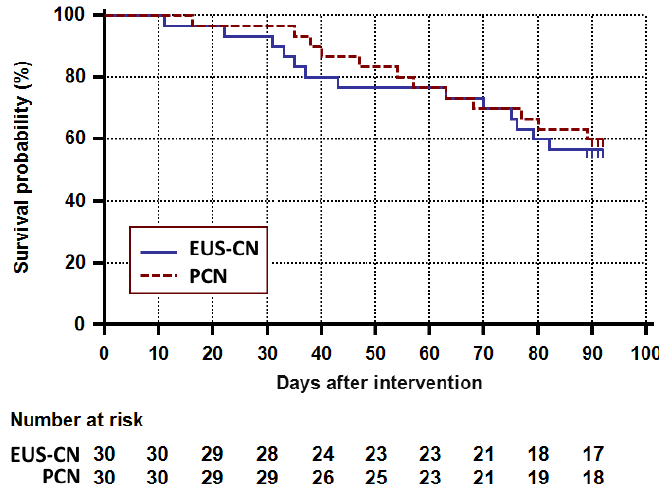
Figure 4. Survival analysis in patients with pancreatic cancer after EUS-CN or PCN. p -value for the Kaplan–Meier analysis of survival between the two groups was 0.73. EUS-CN, endoscopic ultrasound-guided celiac neurolysis; PCN, percutaneous celiac